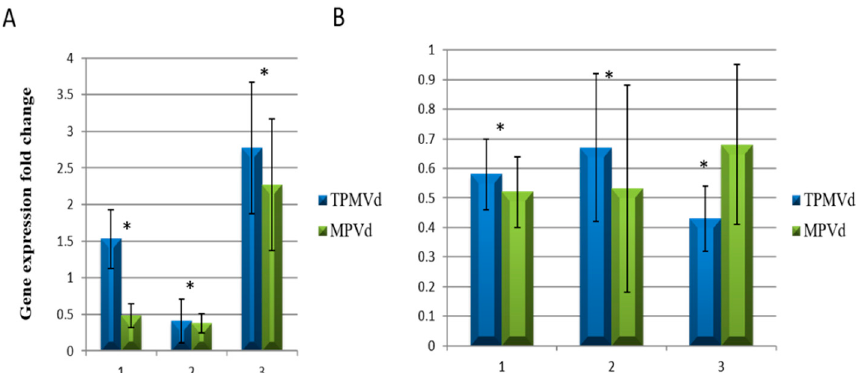
Figure 2. SlBIGPETAL1 and SlOVA6 time course gene expression comparison of TPMVd and MPVd- infected vs mock-inoculated tomato plants. ( A ) SlBIGPETAL1 and ( B ) SlOVA6 gene expression during three infection stages: 1, early infection; 2, middle infection and 3, late infection. Gene expression values are relative to mock-inoculated controls to which a value of 1 was assigned. The EF-1 α elongation factor gene was used as an internal reference. Error bars indicate two times the value of the SD for the corresponding data set. Asterisks indicate statistical significance when analyzed using a paired t -test ( p < 0.05). Where both treatments are statistically significant from mock-inoculated controls, one asterisk is placed above the bars.